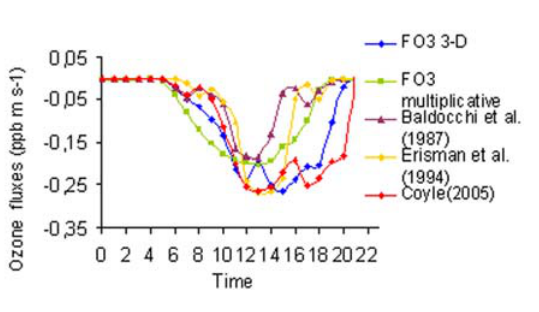
FIGURE 3. FO 3 for anthesis at 2001. Authors references indicate the resistance-type model used. Data compared are 1-h average values taken from 10-min average values.